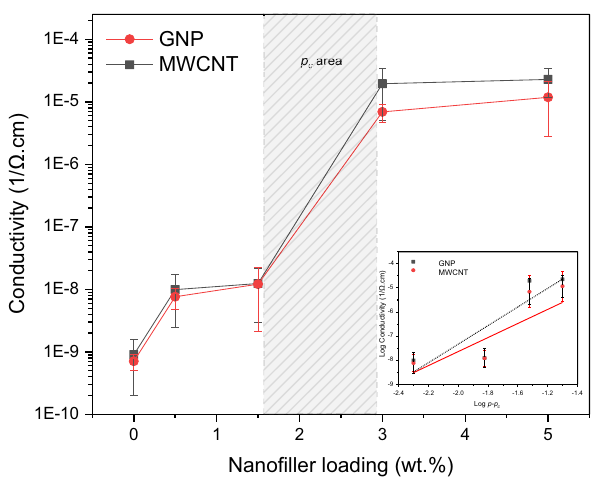
Figure 2: Conductivity of GNP - glass and MWCNT - glass